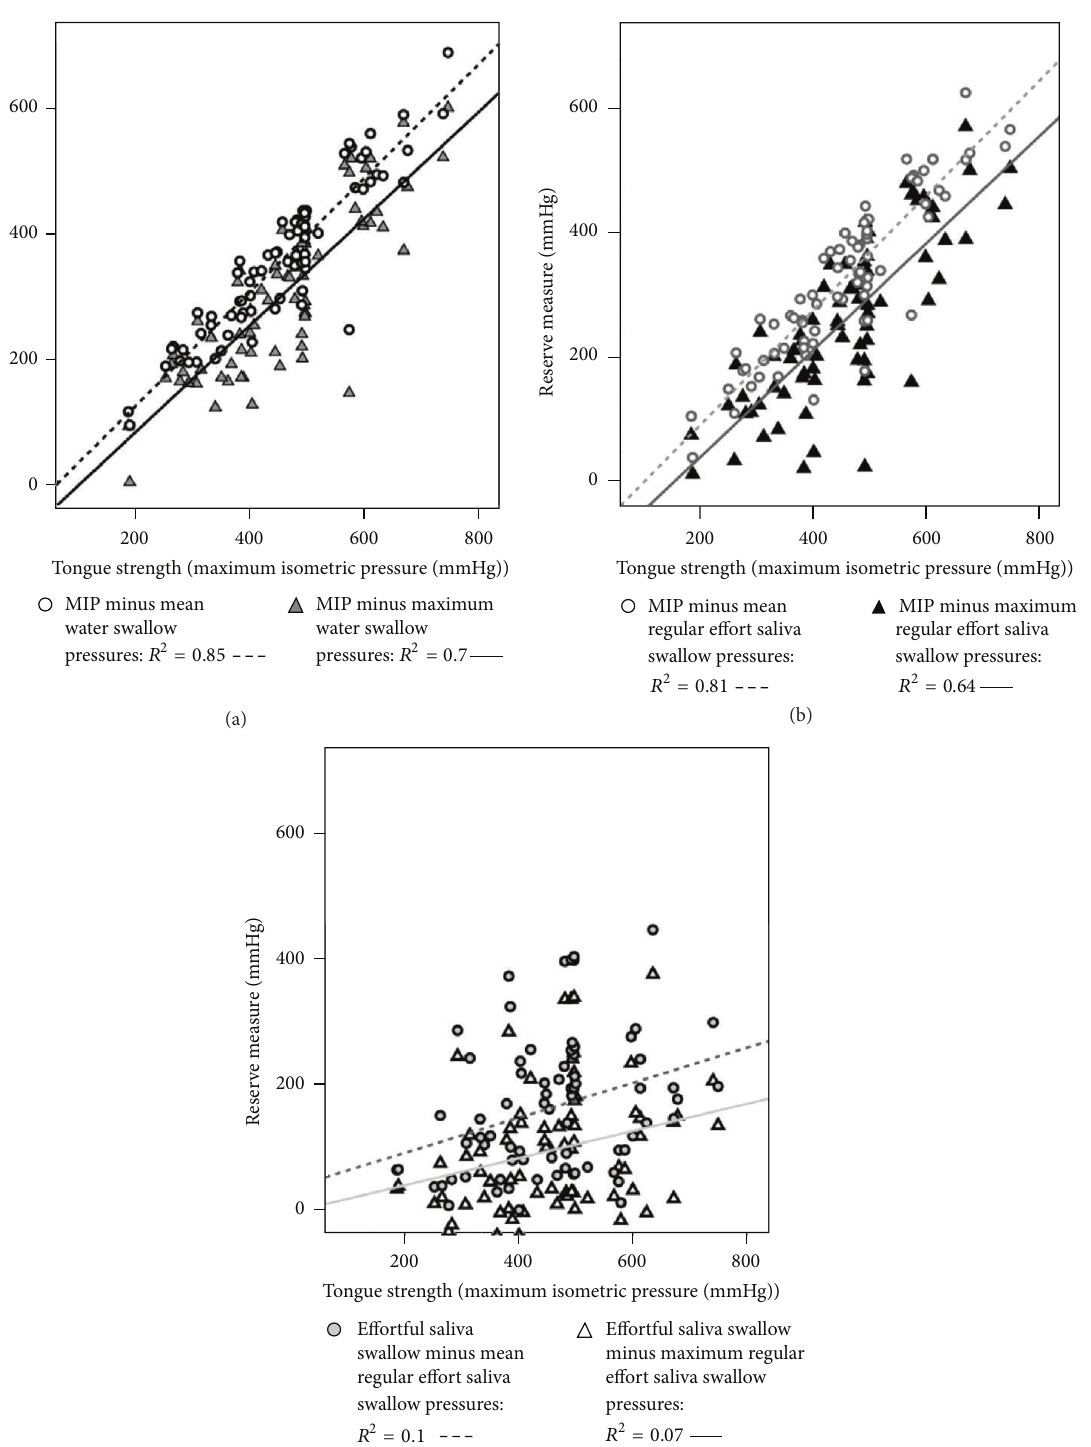
Figure 2: (a) Scatter plot showing the relationship between functional reserve measures comparing maximum isometric pressure (MIP) to water swallowing pressures and tongue strength, as measured by MIP. (b) Scatter plot showing the relationship between functional reserve measures comparing maximum isometric pressure (MIP) to regular effort saliva swallowing pressures and tongue strength, as measured by MIP. (c) Scatter plot showing the relationship between functional reserve measures comparing maximum effortful saliva swallowing pressures to regular effort saliva swallowing pressures and tongue strength, as measured by